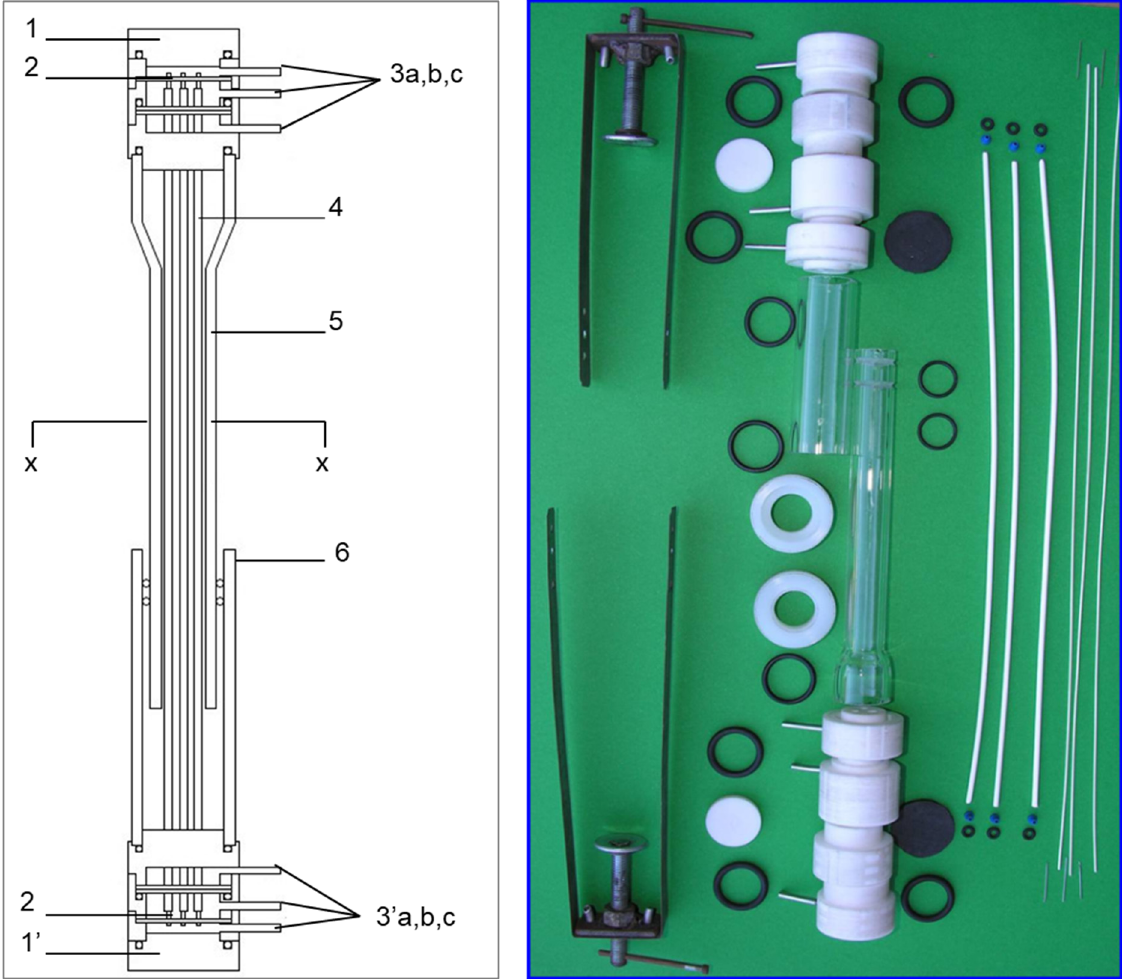
Figure 1. Longitudinal schematic section and parts of the annular contactor. (1, 1’) stopper made of polytetrafluoroethylene (PTFE); (2) first hollow fiber with a smaller diameter; (3a,b,c, 3’a,b,c) threaded spouts (in steel) for the feeding (inlet/outlet) of the feed, receiving and membrane solutions; (4) second hollow fiber with a larger diameter; (5) first cylinder (glass) with a smaller diameter; (6) second cylinder (glass) with a larger diameter.